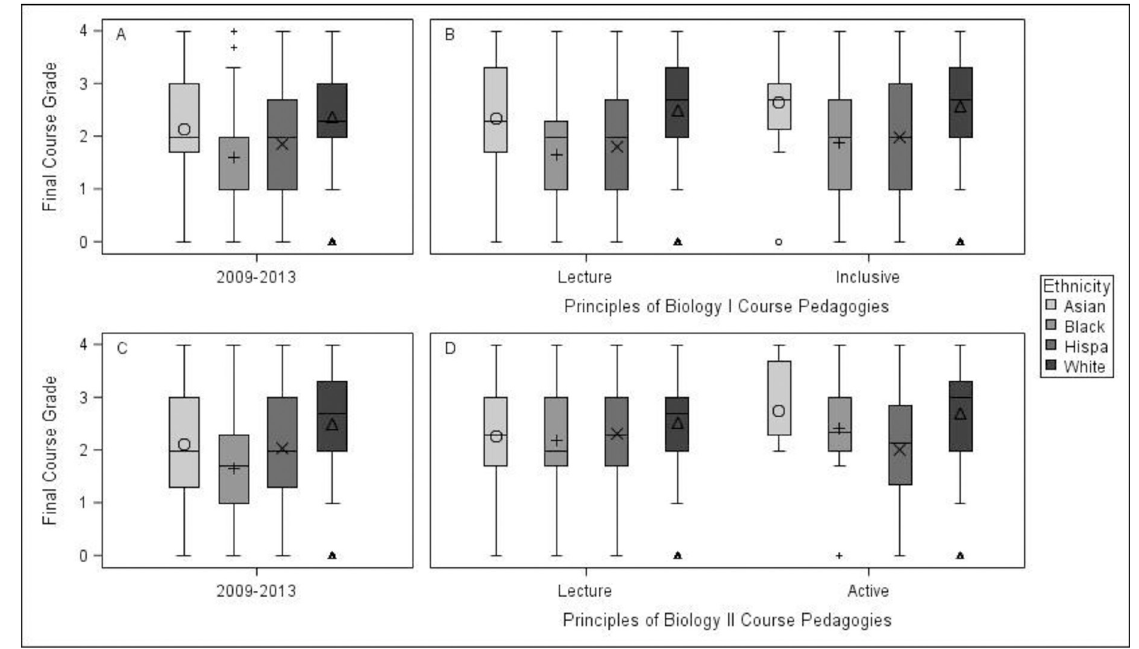
Fig 1. Panel A: Analysis of variance detected achievement gaps in Principles of Biology I between 2009–2013 (F(3, 4423) = 62.75, p < .0001, R 2 = 0.041, 95%CI [0.030, 0.052]). (Demographic group sizes, n = 198 Asian, 269 Black, 421 Hispanic, and 3702 White) Panel B: ANOVA detected medium differences in final grades for the first introductory biology course during 2014–2018 between ethnicities for the lecture- styled sections (F(3, 3398) = 70.88, p < .0001, R 2 = 0.059, 95% CI [0.044, 0.074], Cohen’s d = 0.68 (White and Black students), 0.57 (White and Hispanic students)) and the inclusive section (F(3, 565) = 10.61, p < .0001, R 2 = 0.053, 95% CI [0.017, 0.089], Cohen’s d = 0.58 and 0.55 respectively). (Demographic group sizes for lecture sections, n = 172 Asian, 217 Black, 426 Hispanic, and 2,705 White; Demographic group sizes for inclusive treatment, n = 17 Asian, 42 Black, 70 Hispanic, and 427 White). Panel C: A Kruskal-Wallis Test detected achievement gaps in Principles of Biology II between 2009–2013 ( χ 2 (3, N = 1889) = 76.513, p < .0001, Cramer’s V = 0.116). (Demographic group sizes, n = 80 Asian, 94 Black, 188 Hispanic, and 1527 White) Panel D: In the second course in the introductory biology sequence, Kruskal-Wallis Tests detected small differences between grades as a function of student ethnicity in the lecture sections ( χ 2 (3, N = 832) = 9.924, p = 0.019, Cramer’s V = 0.063) but not in the active learning section ( χ 2 (3, N = 249) = 7.099, p = 0.069, Cramer’s V = 0.097). (Demographic group sizes for lecture sections, n = 37 Asian, 42 Black, 84 Hispanic, and 576 White; Demographic group sizes for active sections, n = 7 Asian, 10 Black, 16 Hispanic, and 216